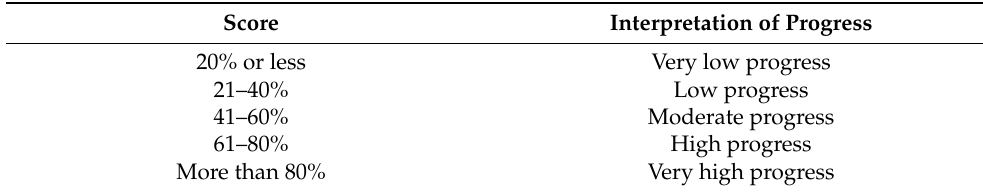
Table 1. Classification of the NCD scorecard progress by